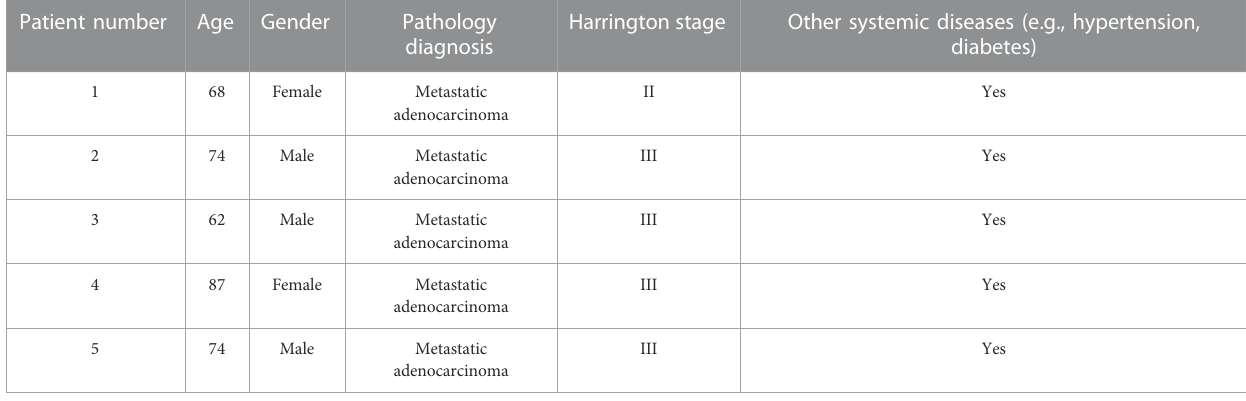
TABLE 1 Clinical characteristics of the fi ve patients.